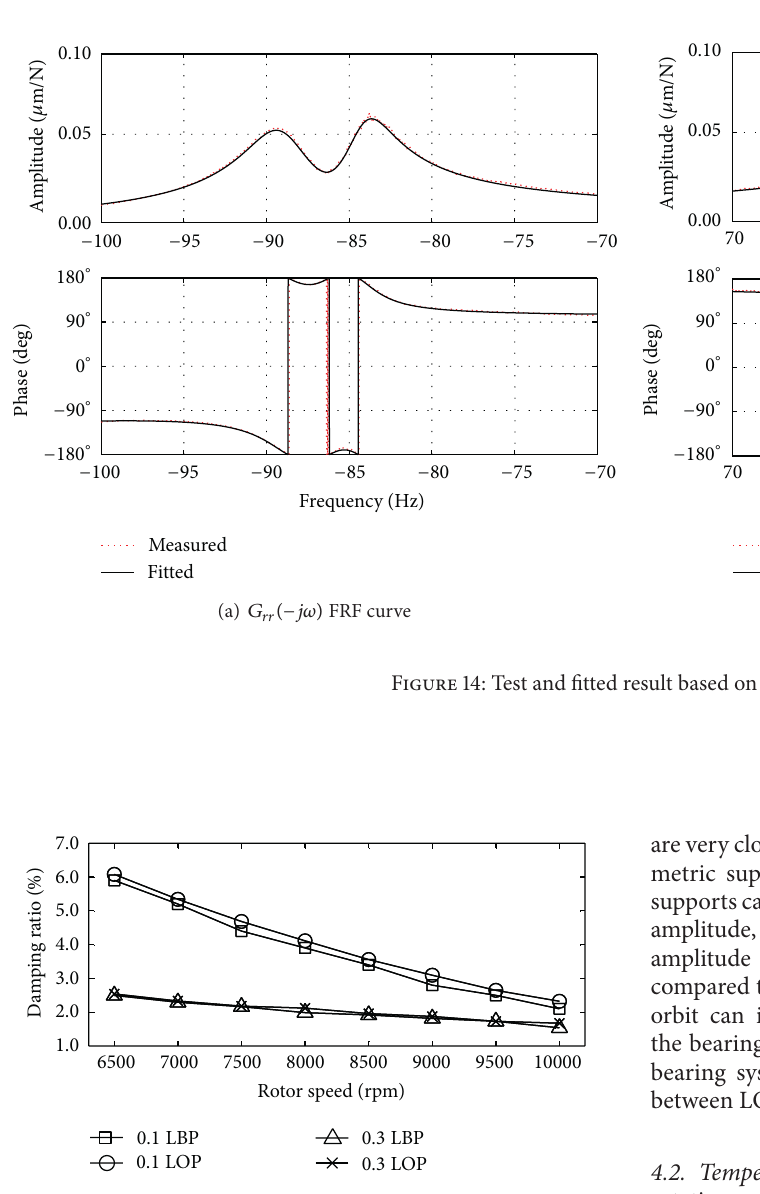
Figure 15: The influence of rotating speed on the stability of